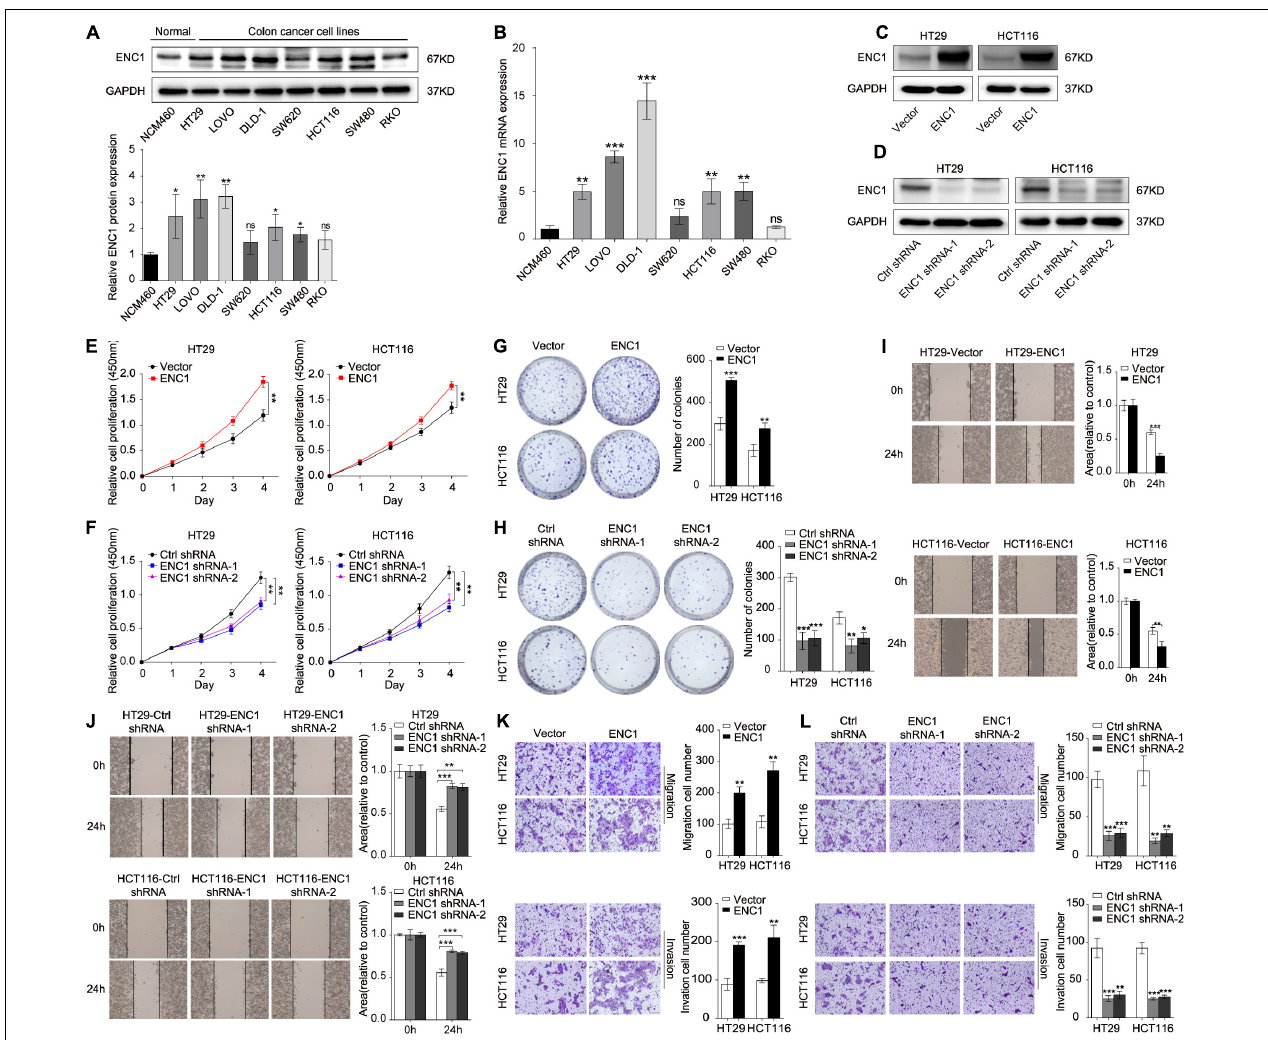
FIGURE 2 | ENC1 regulates proliferation, migration, and invasion of CRC cells. (A) Endogenous ENC1 protein expression status was tested in human normal colonic epithelial cells (NCM460) and CRC cells (HT29, LOVO, DLD-1, SW620, HCT116, SW480, and RKO) by Western blotting. (B) Endogenous ENC1 mRNA expression status was compared between NCM460 and CRC cells by qRT-PCR. Western blot analysis of ENC1 protein expression levels in ENC1 overexpression (C) and ENC1 knockdown (D) CRC cells HT29/HCT116. (E,F) CCK-8 and (G,H) colony formation assays were performed to assess cell proliferation in CRC cells with ENC1 overexpression or knockdown. Wound-healing assay was used to detect cell migration ability in ENC1 overexpression (I) and ENC1 knockdown (J) CRC cells. Transwell assays showed the effect of ENC1 overexpression (K) and ENC1 knockdown (L) on CRC cell migration and invasion (left: representative images; right: quantitative analyses). Results are presented as the mean ± SD of three independent experiments. * P < 0.05, ** P < 0.01, and *** P <